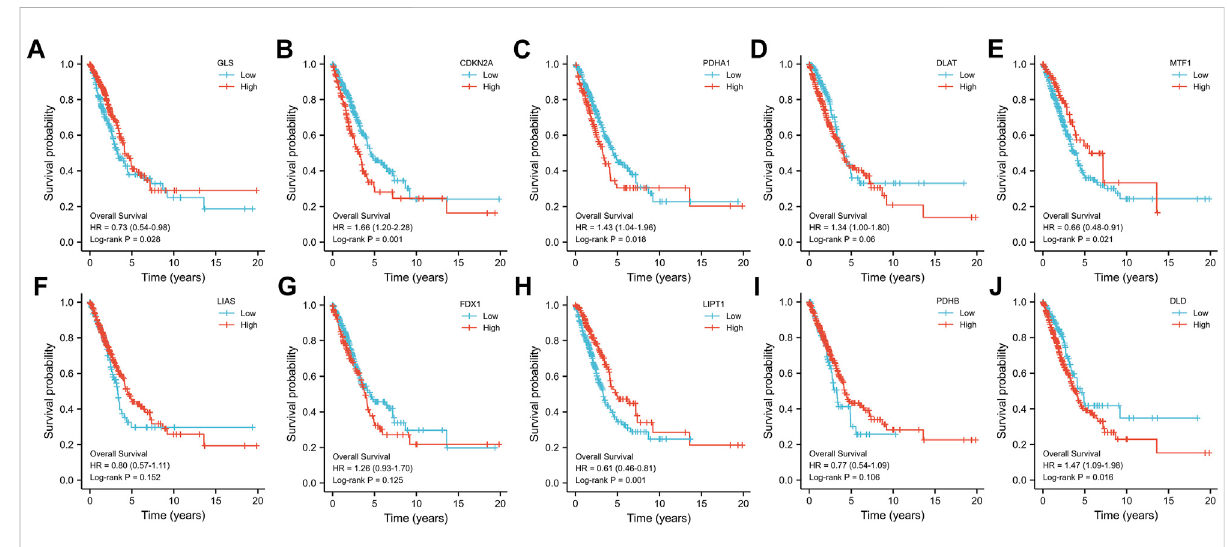
FIGURE 3 Prognosticvalueof 10CRGs in LUAD. The OS curves of GLS (A) , CDKN2A (B) , PDHA1 (C) ,DLAT (D) ,MTF1 (E) ,LIAS (F) ,FDX1 (G) , LIPT1 (H) ,PDHB (I) , and DLD (J) in patients with LUAD in the low and high expression